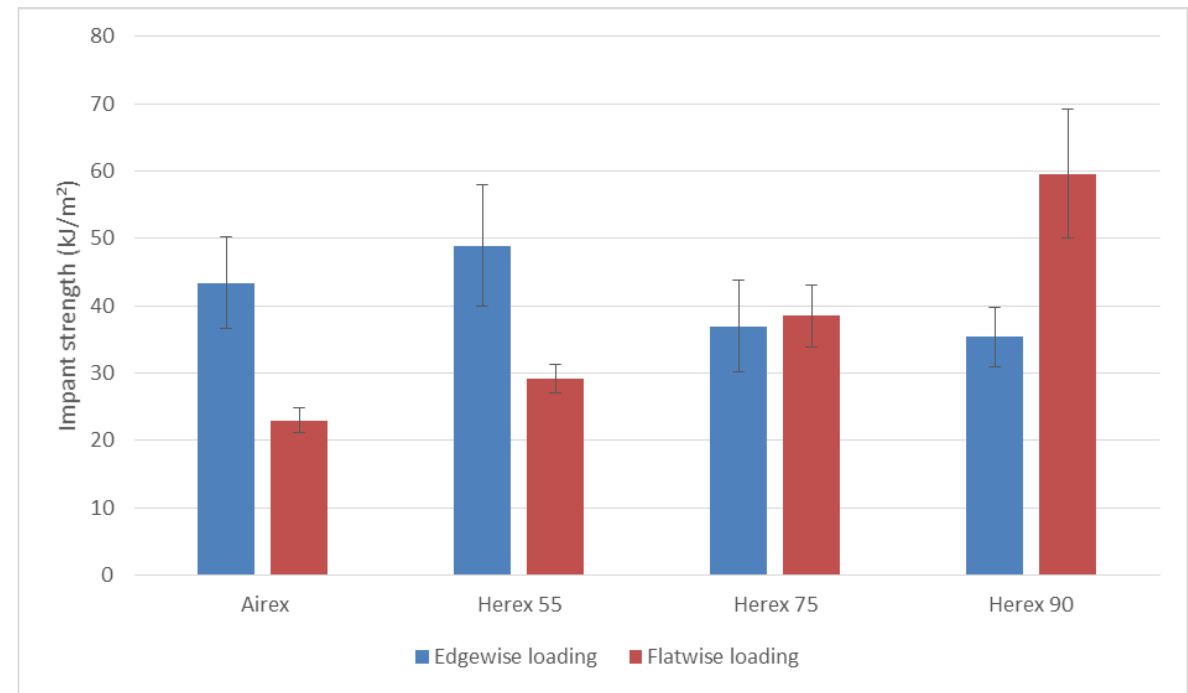
Figure 3. Comparison of impact strength of the tested composites under edgewise and flatwise loading.